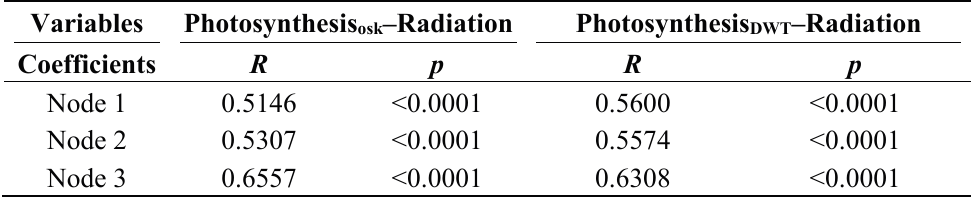
Table 3. Photosynthesis–radiation correlation results with and without DWT filtering.